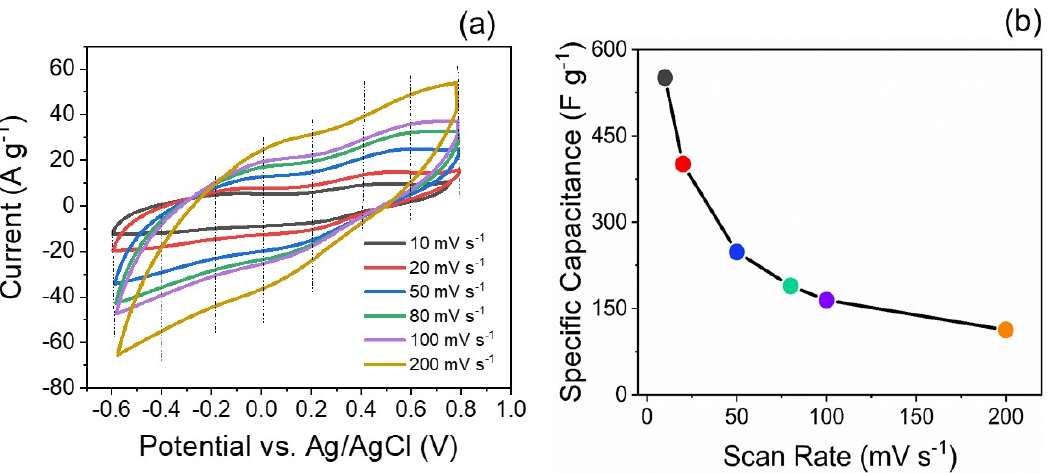
Figure 3. Electrochemical performance of the semi-polycrystalline polyaniline in aqueous electrolyte: ( a ) cyclic voltammograms obtained at different scan rates ranging from 10–200 mV s − 1 ; ( b ) evolution of specific capacitance with respect to the different scan